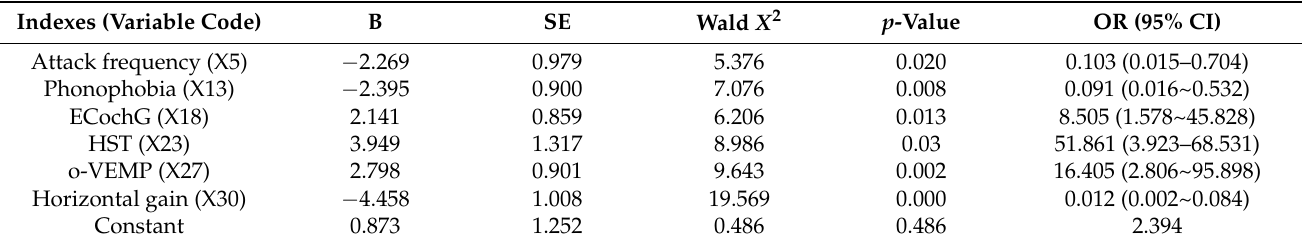
Table 3. Multivariate logistic regression analysis of clinical and auditory-vestibular function features in patients with VM and MD.